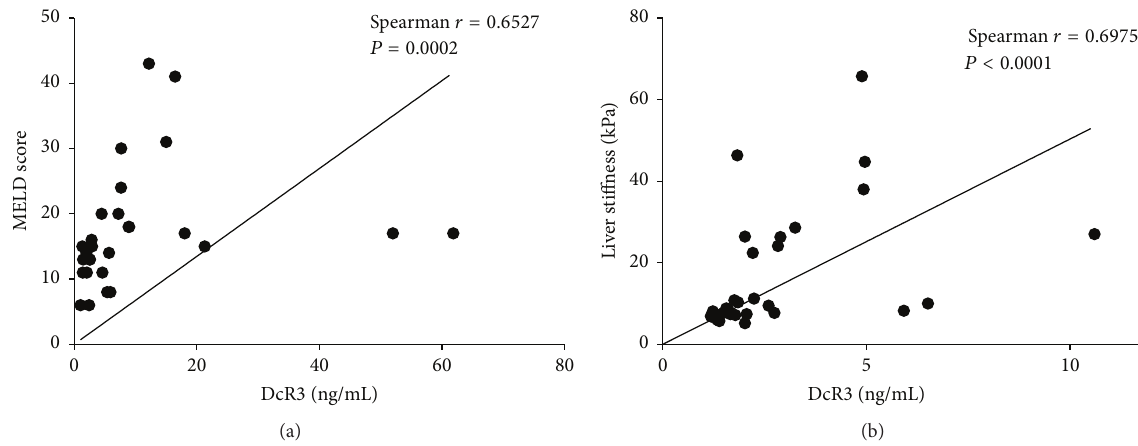
Figure 2: Serum concentration of DcR3 strongly correlates with markers of disease progression in patients with chronic liver disease. The serum concentration of DcR3 was measured by ELISA. Ishak scores (histological stage) were retrieved from the histological reports from patients with available liver biopsies. MELD scores were calculated for cirrhotic patients. The correlation of sDcR3 concentration with (a) the MELD score of patients with cirrhosis is shown; (b) the liver stiffness values of patients with chronic liver disease as measured by shear wave elastography. Statistical significance of correlation was calculated by use of Spearman’s 𝑟 -test.